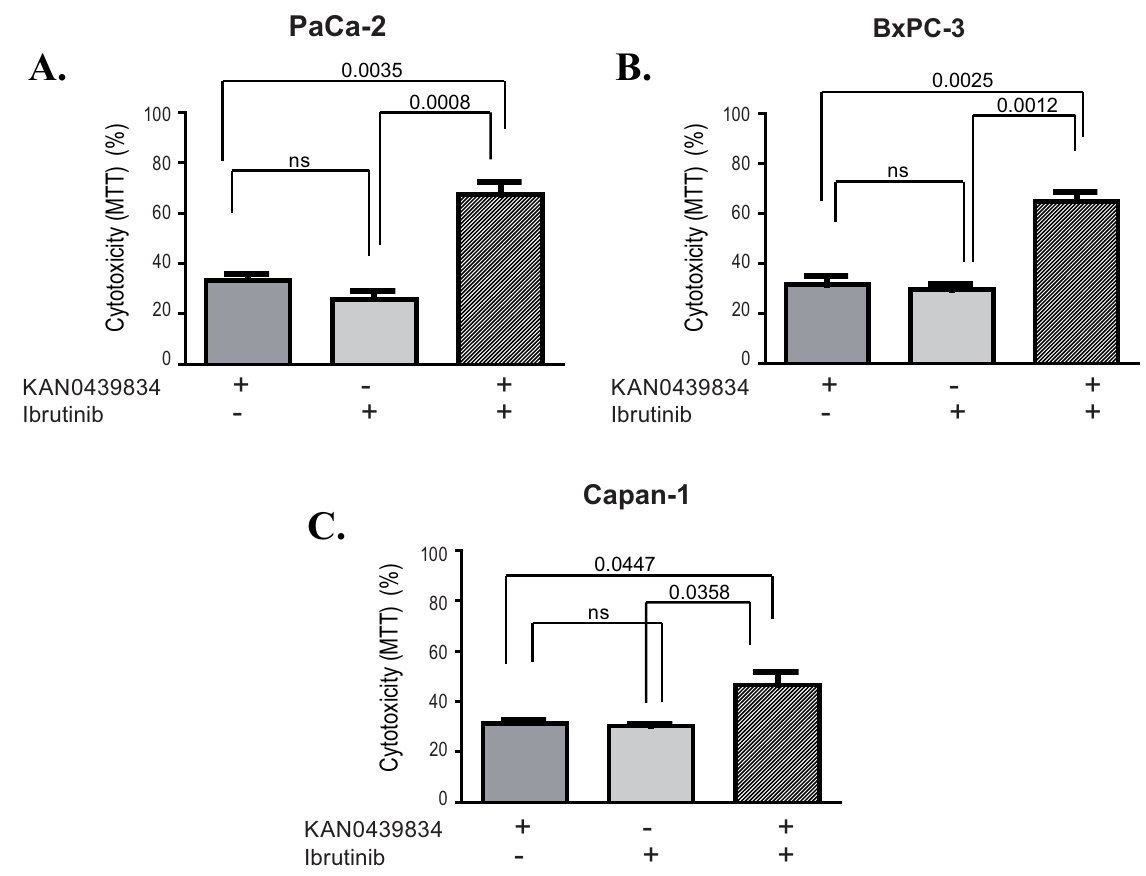
Fig 6. Cytotoxicity (%) (mean ± SEM) of three pancreatic cell lines cultured (72 h) with KAN0439834 and ibrutinib alone and in combination using EC 30 value concentrations for the different drugs and cell lines respectively. Statistics are shown at the